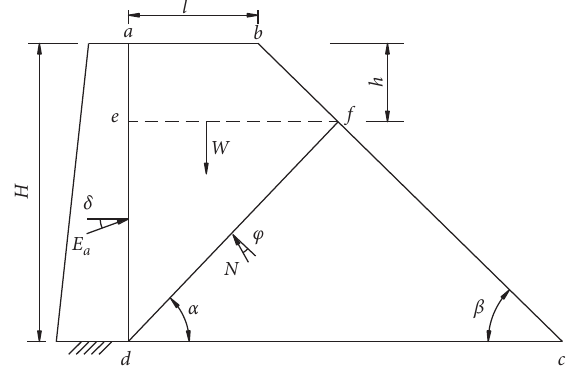
Figure 1: Slip surface through the slope